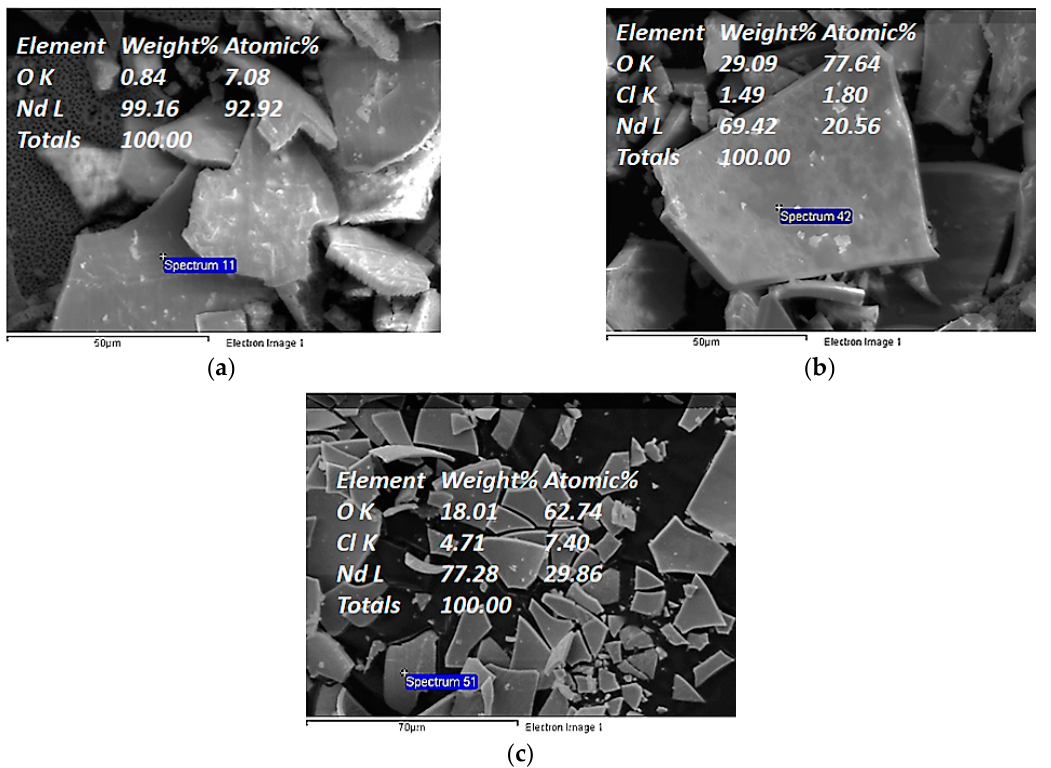
Figure 8. SEM-EDS analysis of the electrodeposits produced at ( a ) 30 °C, ( b ) 50 °C, and ( c ) 70 °C.